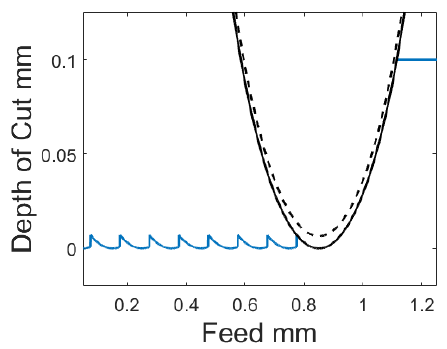
Figure 2. Simulated surface created by assuming some constant amount of material is pushed to the side during each workpiece revolution.